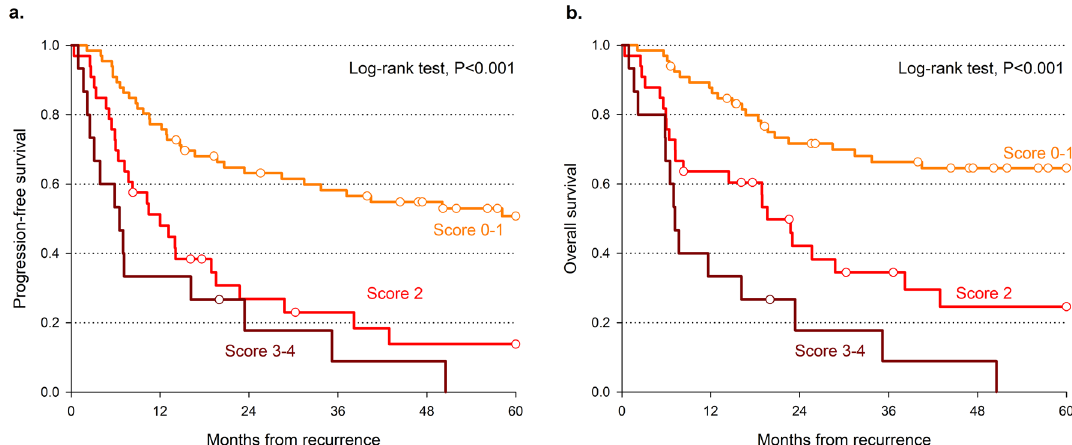
Figure 1. Progression free survival ( a ) and overall survival ( b ) according to prognostic score values. Survival curves were estimated according to Kaplan–Meier methods, and differences across score levels were evaluated through log-rank